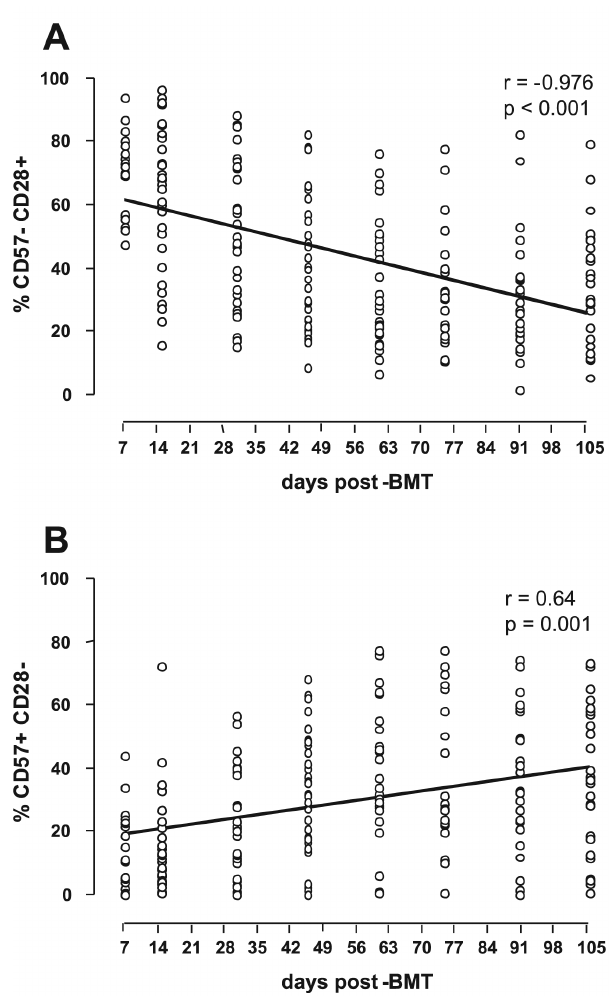
Figure 2 - Relative decrease of CD57-CD28+ subset (A) and a relative increase of CD57+CD28- subset (B) in the CD8+ T lymphocyte population occur continuously after BMT, as assessed by Spearman’s correlation